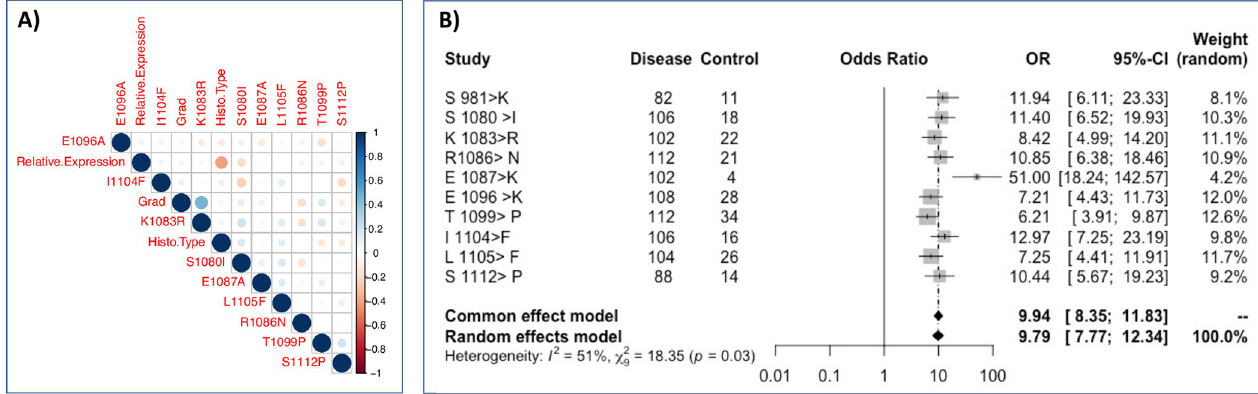
Fig 3. Survival analysis of Rbl2/p130 C-terminus mutations in breast cancer. Individual panel represents survival curve calculated through Kaplan Meier analysis for S1080, K1083, R1086, T1099 and I1104 mutations. Among all the five mutations, patients with K1083R mutation exhibited poor survival outcome.